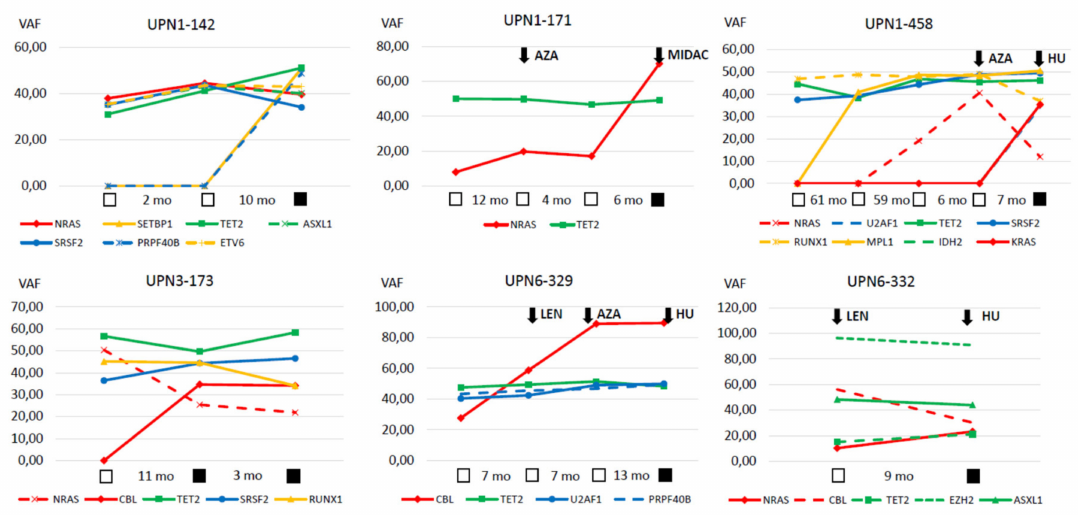
Figure 4. Serial mutation analysis in individual patients. The variant allele frequencies of 6 individual patients are shown at di ff erent time points during the course of their disease. Open squares indicate time points pre transformation and closed squares time points after